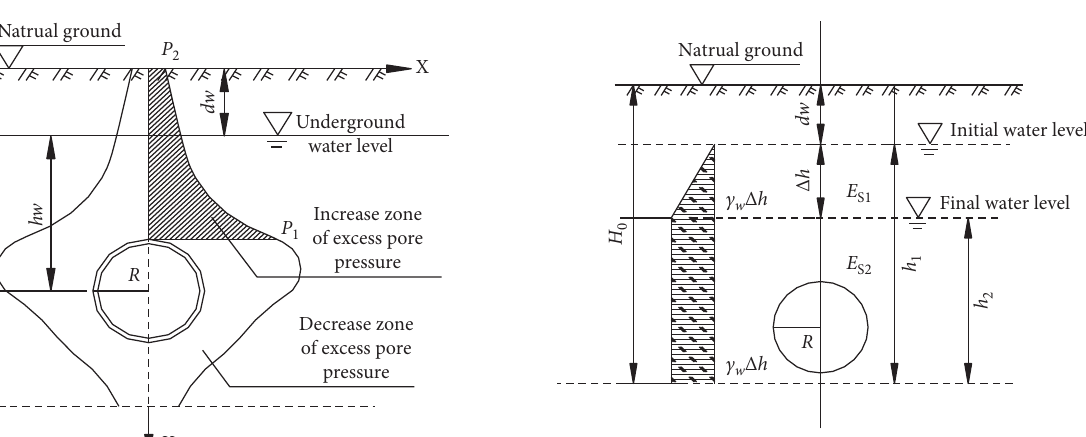
Figure 6: Additional stress caused by the decline of the under- ground water